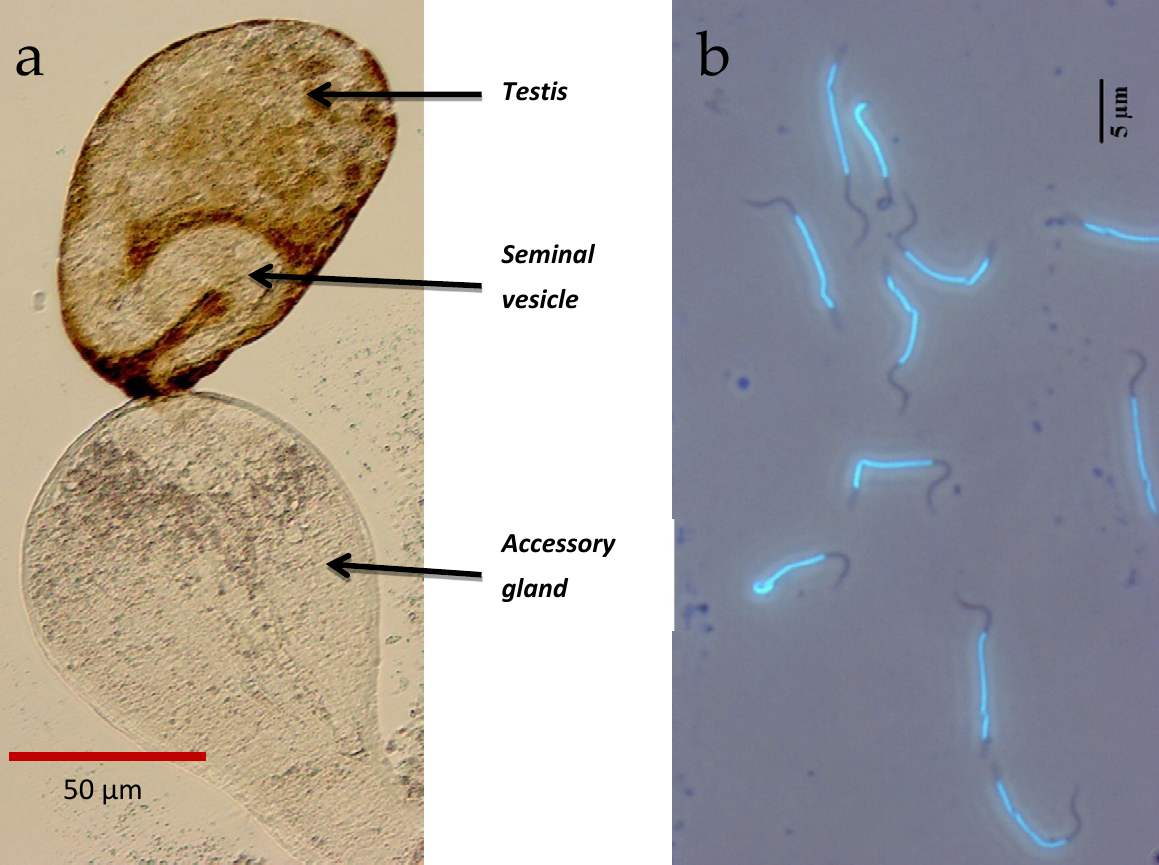
Figure 1. M. rufiventris half reproductive tract under phase contrast ( a ); spermatozoa labeled with DAPI ( b ). Spermatozoa are short (ca 15.5 µ m, n = 8) and the nucleus is longer than the flagellum (Figure 1). They are individualized and not embedded in a mass or a cohesive fluid during storage in seminal